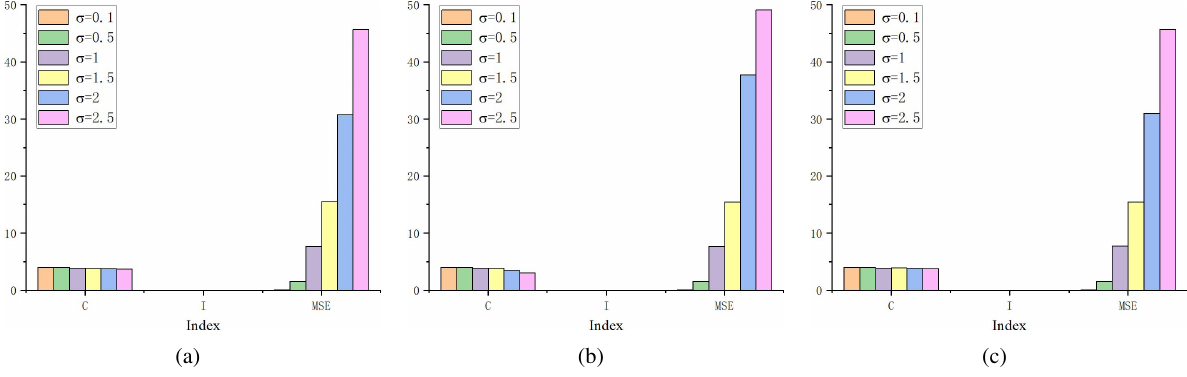
Fig. 5 Simulation results when N = 200, R = 10 and ρ = 0.5. (a) The result of ALASSO penalty function; (b) the result of LASSO penalty function; and (c) the result of SCAD penalty function. ALASSO, adaptive least absolute shrinkage and selection operator; LASSO, least absolute shrinkage and selection operator; SCAD, smoothly clipped absolute deviation.